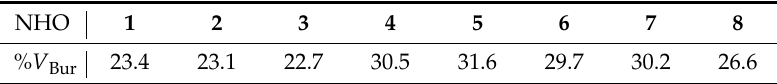
Table 4. Buried volume as calculated for MgCl 2 (NHO)(THF)